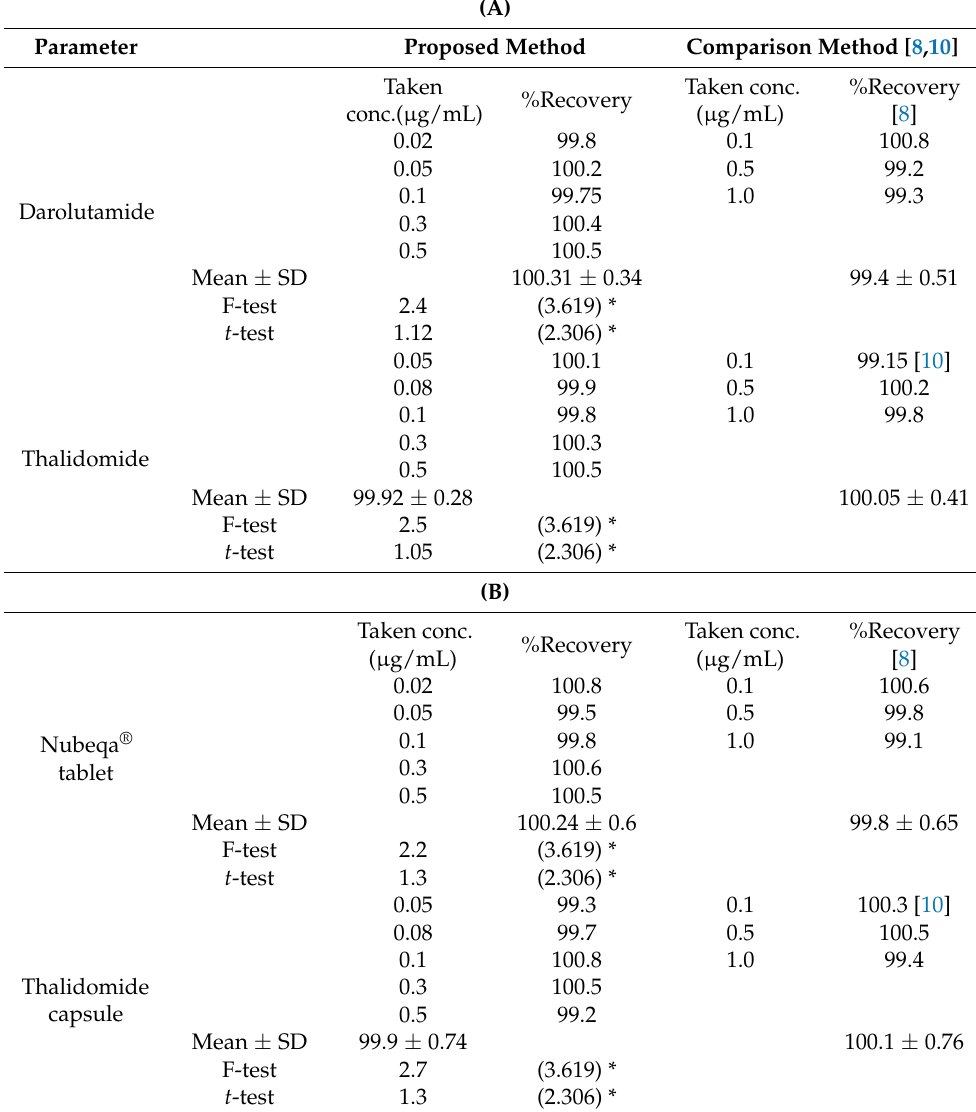
Table 2. ( A ): Application of the proposed method to the determination of darolutamide and thalido- mide raw materials. ( B ): Application of the proposed method to the determination of darolutamide and thalidomide dosage form.